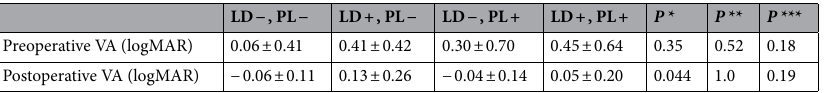
Table 2. Preoperative and postoperative visual acuity based the presence or absence of lattice degeneration and pigmentary lesion. The VA values are presented as the mean ± standard deviation. VA visual acuity, logMAR logarithm of the minimum angle of resolution, LD lattice degeneration . PL pigmentary lesion. The Dunnett test was used to compare the respective VAs of eyes without both LD and PL, eyes with LD and without PL*, eyes without LD and with PL**, and eyes with both LD PL***.